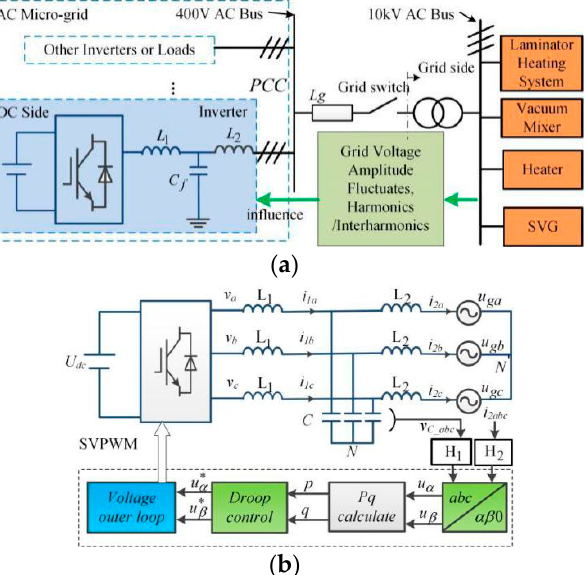
Figure 1. ( a ) Topology of the AC micro-grid in a photo-voltaic panel factory; ( b ) control system structure of the inverter in a grid-connected mode (List of symbols is in Appendix A).